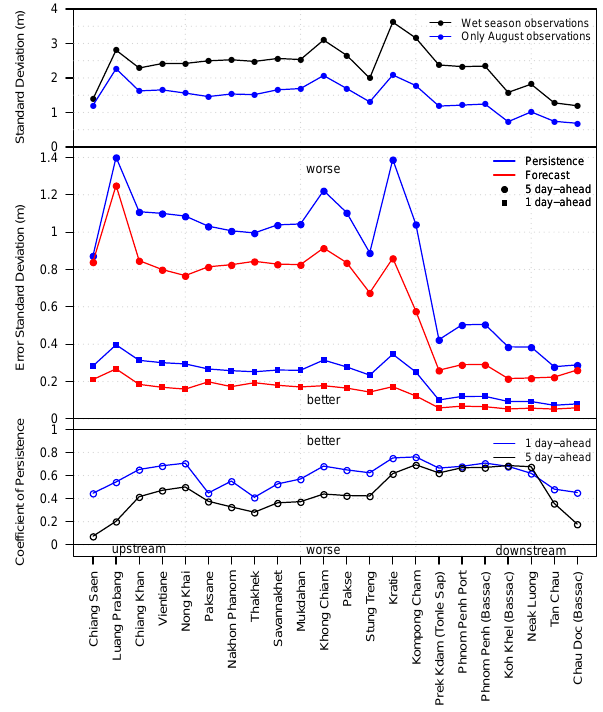
Figure 3. Error standard deviation (middle) and coefficient of per- sistence (bottom) for locations upstream (left) to downstream (right) for wet-season forecasts from 2000 to 2012. The top plot shows the period of record standard deviation for the wet-season obser- vations and the observations for August (only complete forecast- observation pairs were